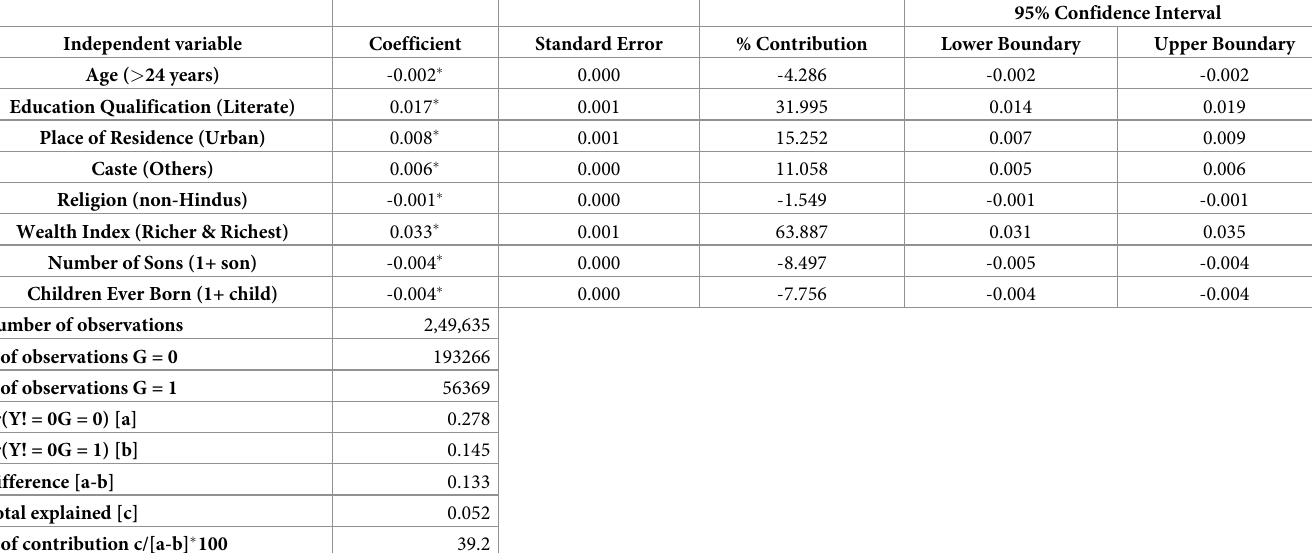
Table 4. Decomposition of mass media exposure by current use of reversible modern methods among married women aged 15–49 years in India, NFHS